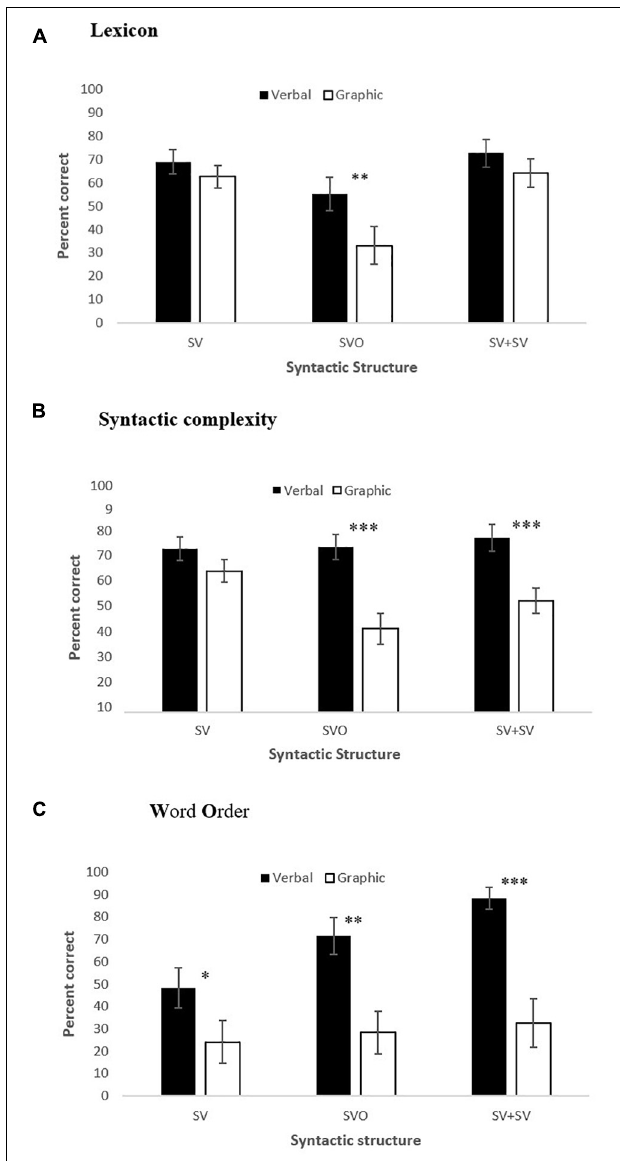
FIGURE 3 | Scores for SV, SVO, and SV + SV clauses when produced in verbal and graphic symbols, separately for (A) lexicon, (B) syntactic complexity, and (C) word order. (A) ∗∗ p < 0.01. (B) ∗∗∗ p <